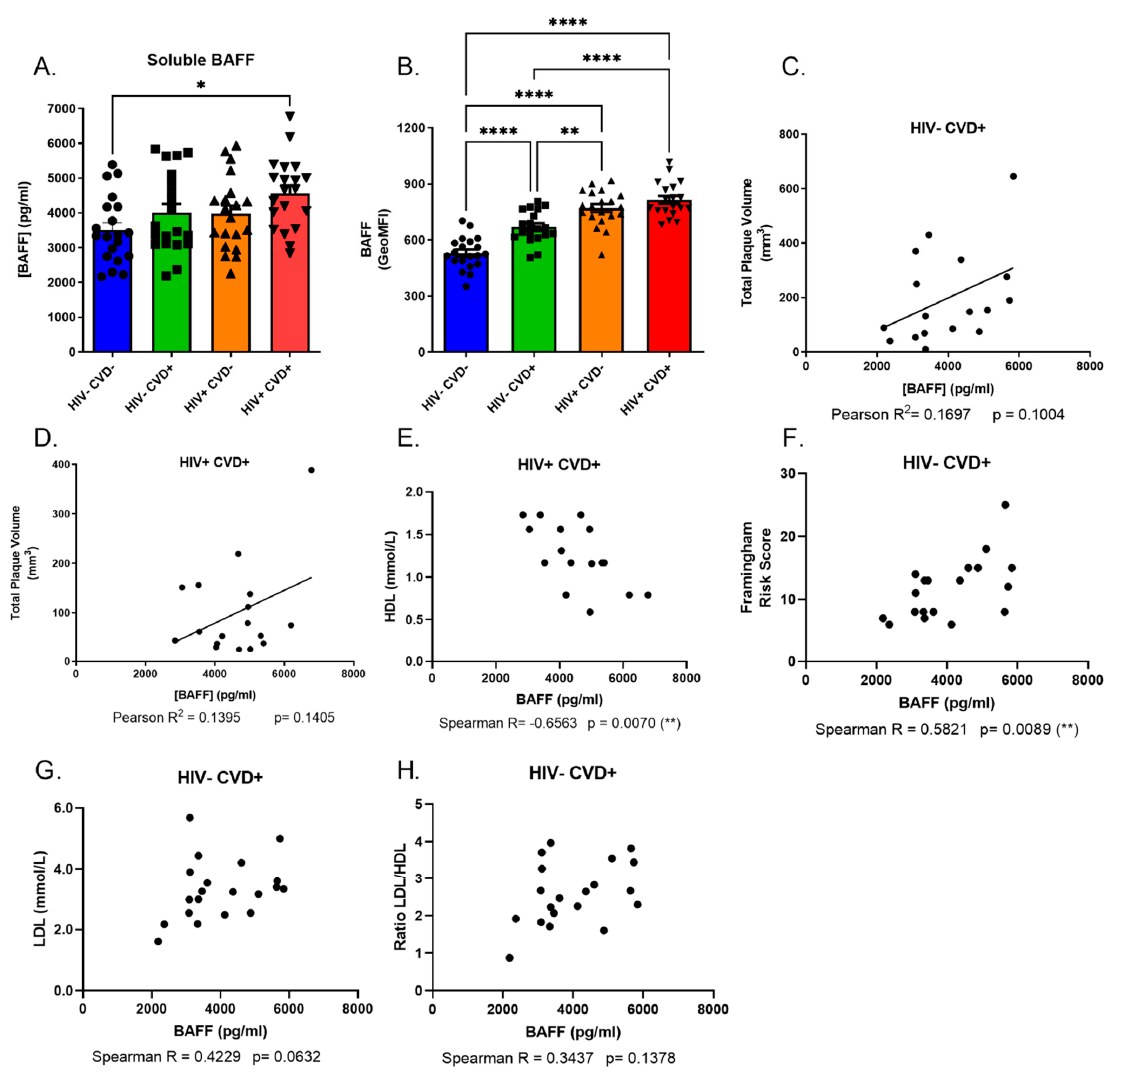
Figure 1. BAFF levels and correlations between soluble BAFF and CVD risk factors in the blood of HIV-uninfected and HIV-infected individuals in the CHACS cohort. Levels of soluble ( A ) and mem- brane-bound ( B ) BAFF in the blood of HIV-uninfected participants, without and with CVD (HIV − CVD − , HIV − CVD+, respectively), and HIV-infected participants, without and with CVD (HIV+ CVD − , HIV+ CVD+, respectively) selected in sub-cohort ( A ). Correlation between total plaque vol- ume (TPV) and soluble BAFF blood levels in HIV − CVD+ ( C ) and HIV+ CVD+ ( D ) participants. Correlation between soluble BAFF and HDL ( E ) blood levels in HIV+ CVD+ participants. Correla- tion between soluble BAFF blood levels and the Framingham risk score ( F ), LDL ( G ) and LDL/HDL (H) ratio in HIV − CVD+ participants. Normality was assessed with the Shapiro-Wilk test. A one- Way ANOVA with a post-hoc Tukey test was used to test for statistical differences between groups in ( A , B ). A Pearson correlation was used to test for correlations in ( C , D ). A Spearman correlation was used to test for correlations in ( E – H ). LDL—low-density lipoprotein; HDL—high-density lipo- protein; GeoMFI—geometric mean fluorescence intensity; CVD—cardiovascular disease. * p < 0.05; ** p < 0.01; **** p < 0.0001.